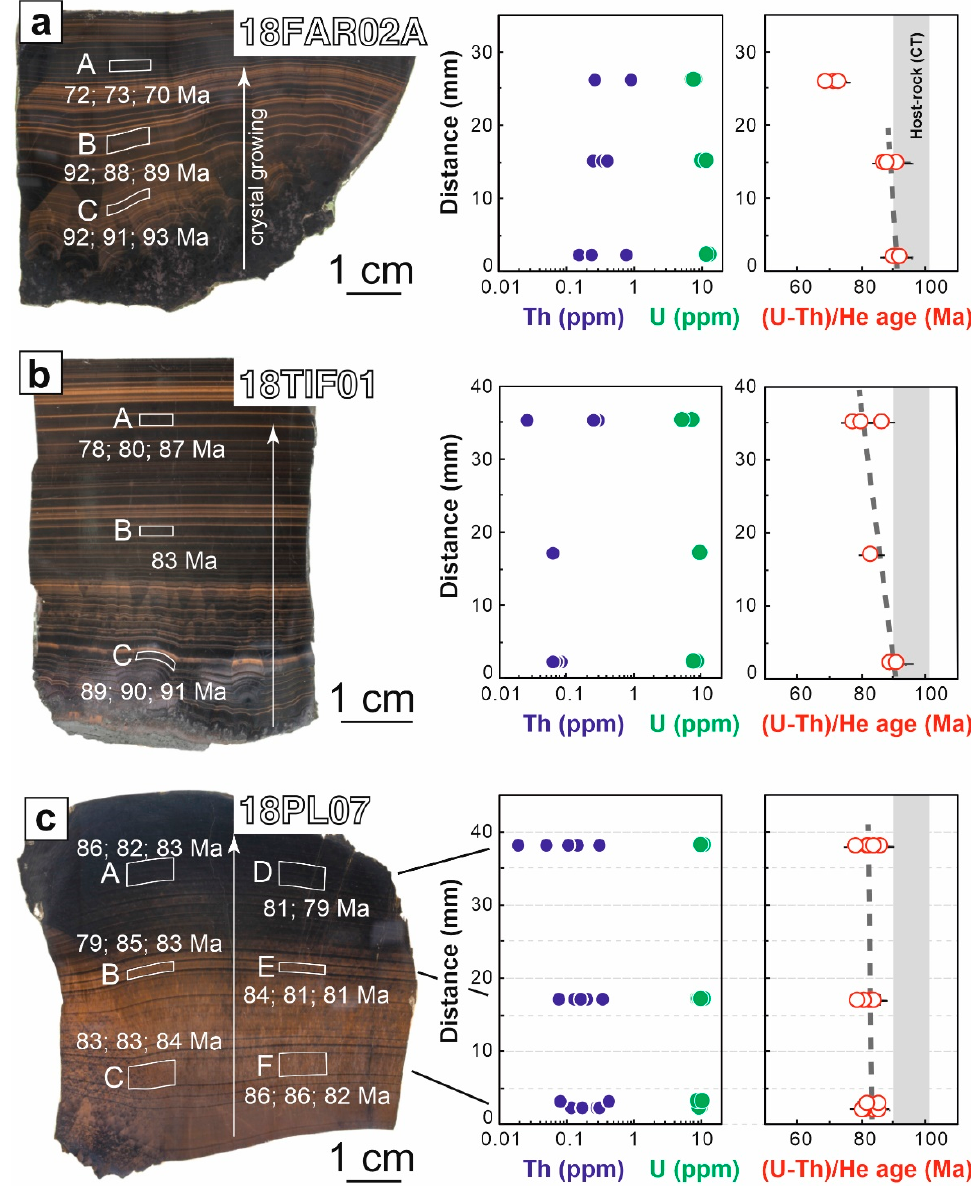
Figure 8. Cavity-filling botryoidal goethite samples ( a ) 18FAR02A, ( b ) 18TIF01 and ( c ) 18PL07 and evolution of Th and U contents and (U-Th)/He ages along transects of the samples. On the sample pictures, the letters A to F and the white rectangular zone refer to the sampling zone given in Table S6.